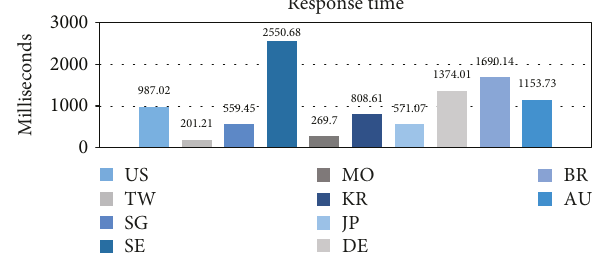
Table 7: Test result of the emulation mode with time (coverage). Number of tested resources Total number of found resources